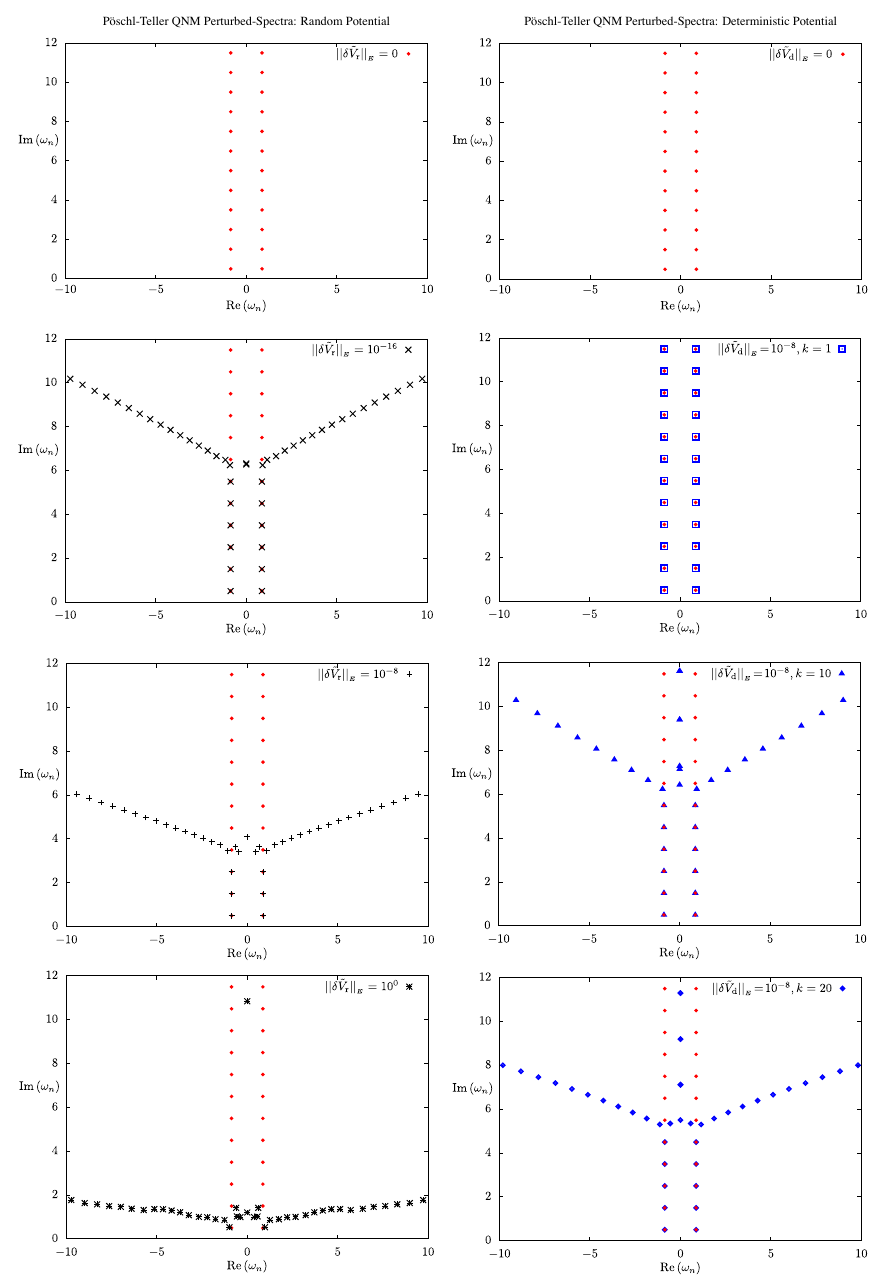
˜ V FIG. 7. Left column: sequence of QNM spectra for the Pöschl-Teller potential subject to a random perturbation δ of increasing size (in r energynorm). Thesequence showshow switchingona perturbationmakes the QNMs migratetoa new branch(thatactuallycloselyfollowsa pseudospectrumcontourline,comparewithFig.5),insuchawaythattheinstabilitystartsappearingathighlydampedQNMsanddescendsin thespectrumastheperturbation grows(unperturbed values,in red,are keptalong the sequence forcomparison). Thetoppanel corresponds to ˜ V 10 − 16 already the nonperturbed potential shown in Fig. 3, the second panel shows how a random perturbation of (energy) norm k δ r k E ¼ ˜ V 10 − 8 already reaches the third overtone.This confirms reachesthe sixth QNM overtone, and,inthethird panel, a perturbationwith k δ r k E ¼ the instability already detected in the pseudospectrum, indicating its high-frequency nature. Crucially, to reach the fundamental mode, a perturbation ofthesame order O ð 1 Þ as thevariationofthe eigenvalue is required,thusdemonstratingthe stability ofthe fundamental QNM in agreement with the pseudospectrum in Fig. 5. Right panel: sequence of QNM spectra for the Pöschl-Teller potential subject to a deterministic ˜ V ∼ cos ð 2 π kx Þ . The first panel again shows the unperturbed potential, whereas the second one shows that a low-frequency perturbation δ d ˜ V 10 − 8 norm (compare with the random case with the same ( k ¼ 1 ) perturbation leaves the spectrum unperturbed, in spite of the k δ d k E ¼